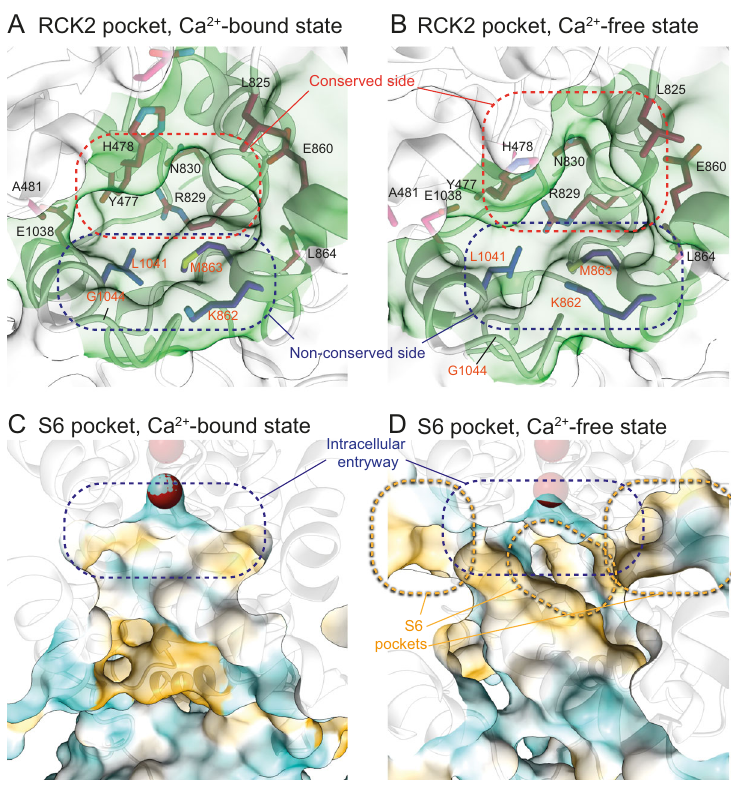
Fig. 3 RCK2 and S6 pockets display characteristics of druggable pockets. A Close-up view of the RCK2 pocket in the Ca 2 + -bound active conformation. Amino acid side chains that line the pocket are shown in stick representation and colored according to conservation from blue (low conservation) to red (high conservation). Residues that are identical between Drosophila Slo and human Slo1 are labeled with black labels, residues that differ with orange labels. Intriguingly, the side of the pocket lined by K862, M863, L1041, and G1044 is not conserved and also differs between Drosophila and human. B Close-up view of the RCK2 pocket in the Ca 2 + -free conformation. The shape of the pocket changes upon Ca 2 + -induced rearrangement of the gating ring. C Surface representation of the central cavity in the Ca 2 + -bound active conformation colored in a gradient from cyan over white to yellow according to increasing molecular lipophilicity potential (MLP). Half of the Slo tetramer was omitted to allow an unobstructed view into the internal pore. The intracellular entryway to the selectivity fi lter is indicated in blue. D Surface representation of the cavity in the Ca 2 + -free inactive conformation. The rearrangement of helix S6 exposes hydrophobic pockets (indicated in orange) in the vicinity of the intracellular